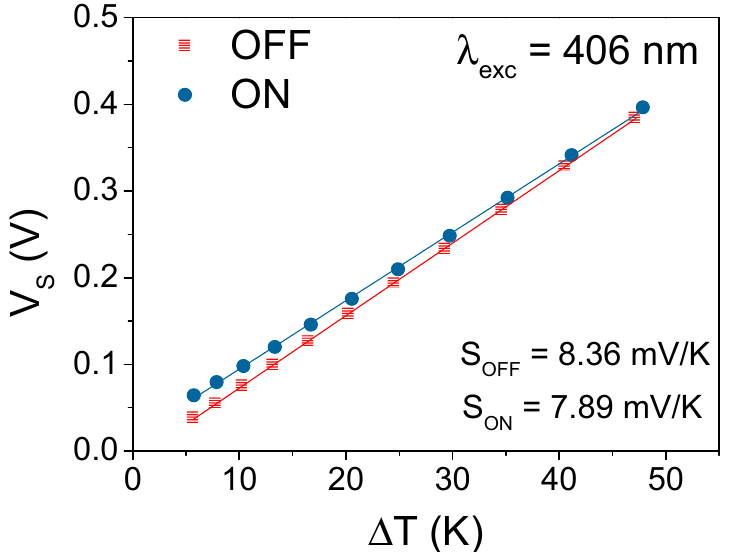
Figure 3. Plot of the Seebeck voltage at open circuit as a function as a function of temperature difference. When the device is illuminated and without